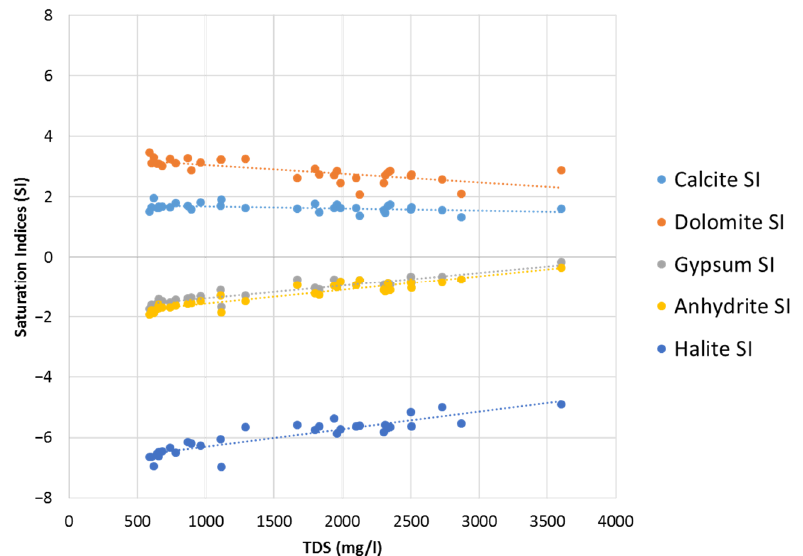
Figure 9. Scatter plots showing the relationship between TDS and the saturation indices of calcite, dolomite, gypsum, anhydrite, and halite minerals.